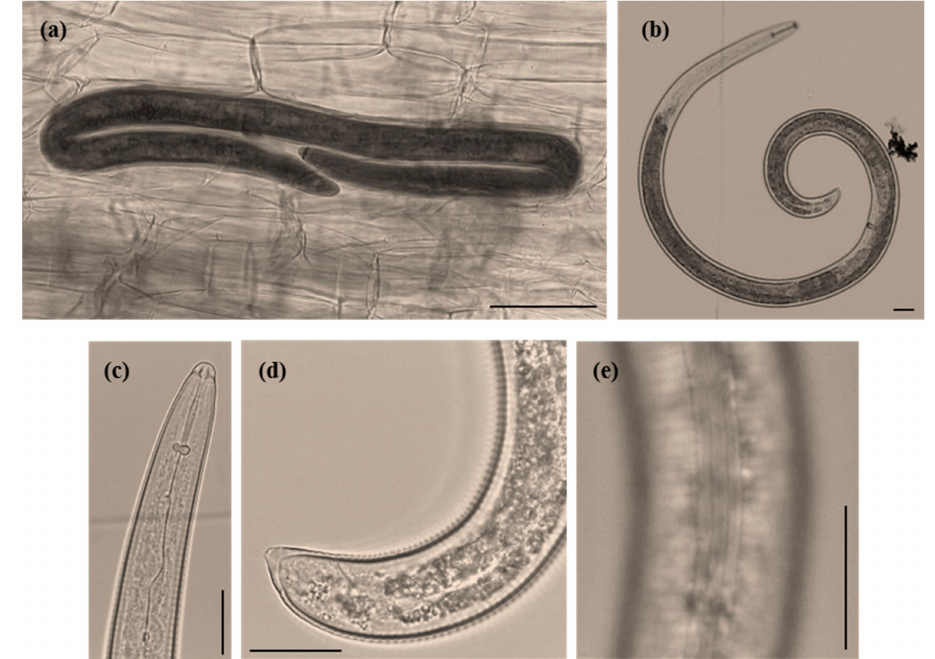
Figure 2. Helicotylenchus dihystera (females) light microscope photographs. ( a ) Infected Ficus microcarpa root. ( b ) Whole specimen. ( c ) Anterior region in lateral view. ( d ) Posterior region in lateral view. ( e ) Lateral field with four lateral lines. Scale bars: 20 µ m ( a – d ), and 50 µ m ( e